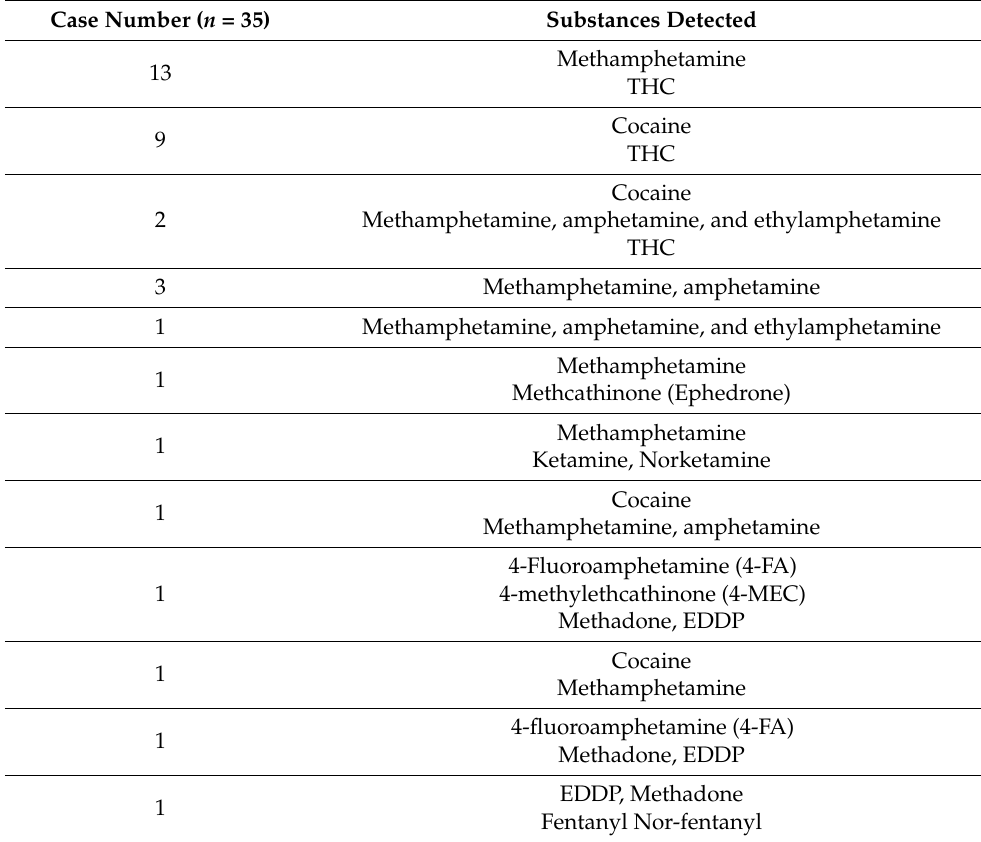
Table 3. Psychoactive substances found in hair from polyconsumer pregnant